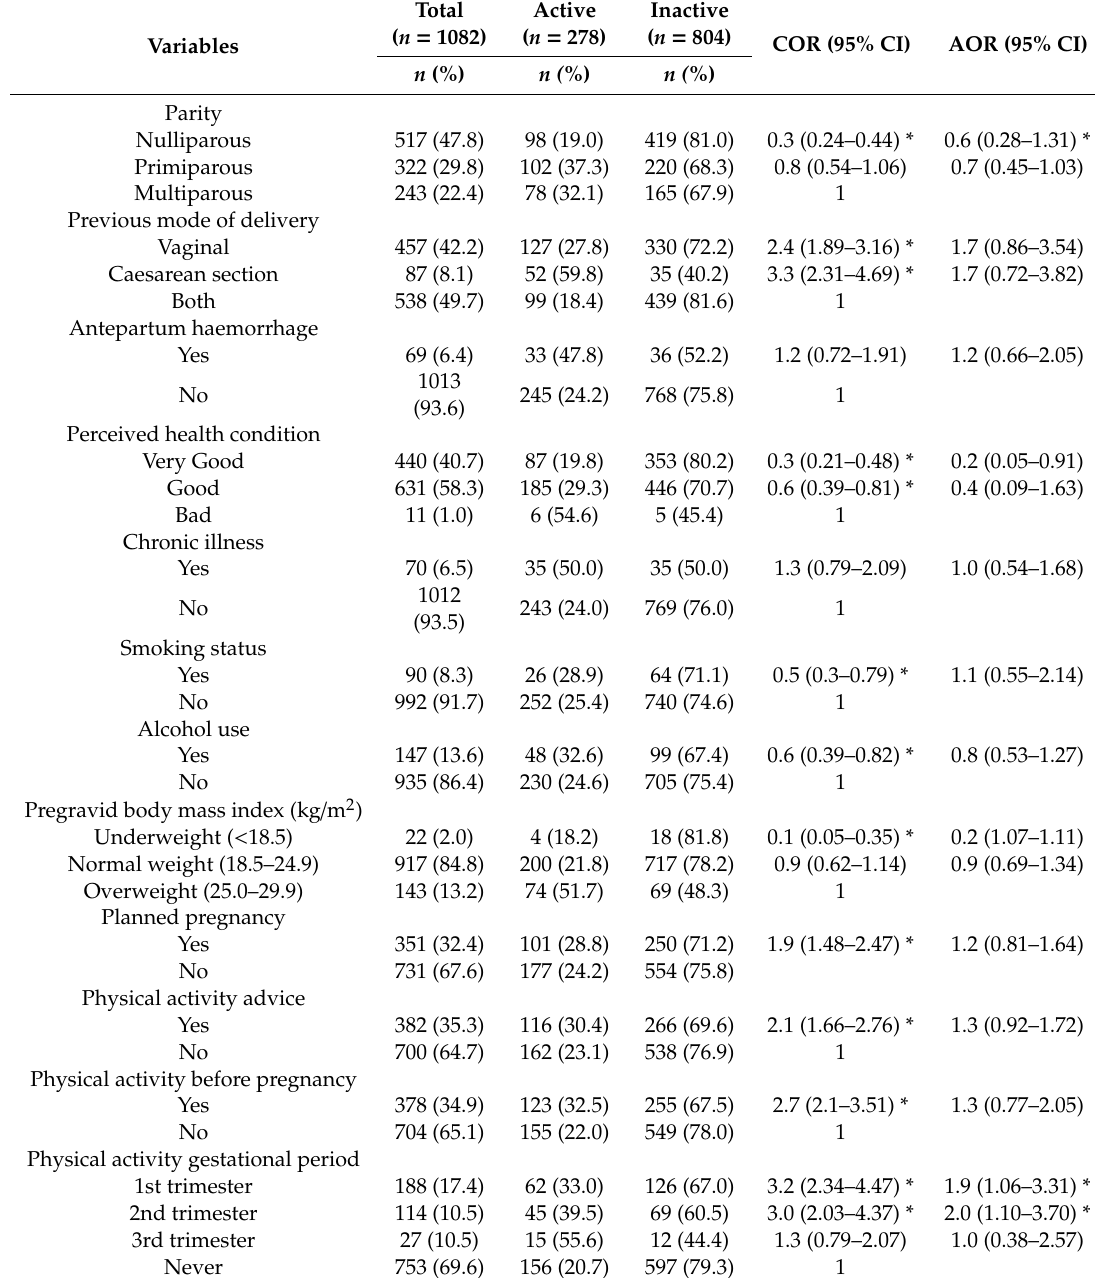
Table 5. Multivariate logistics regression model of physical activity on obstetric and lifestyle